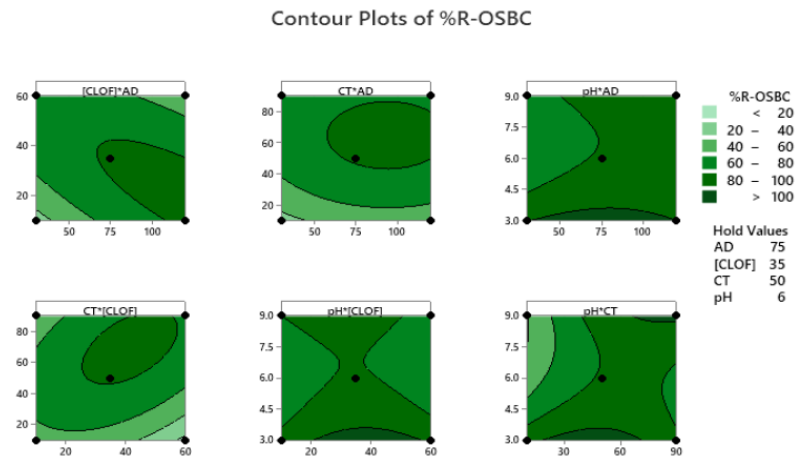
Figure 9. Sample contour plots when %R is the response, using OSBC as an